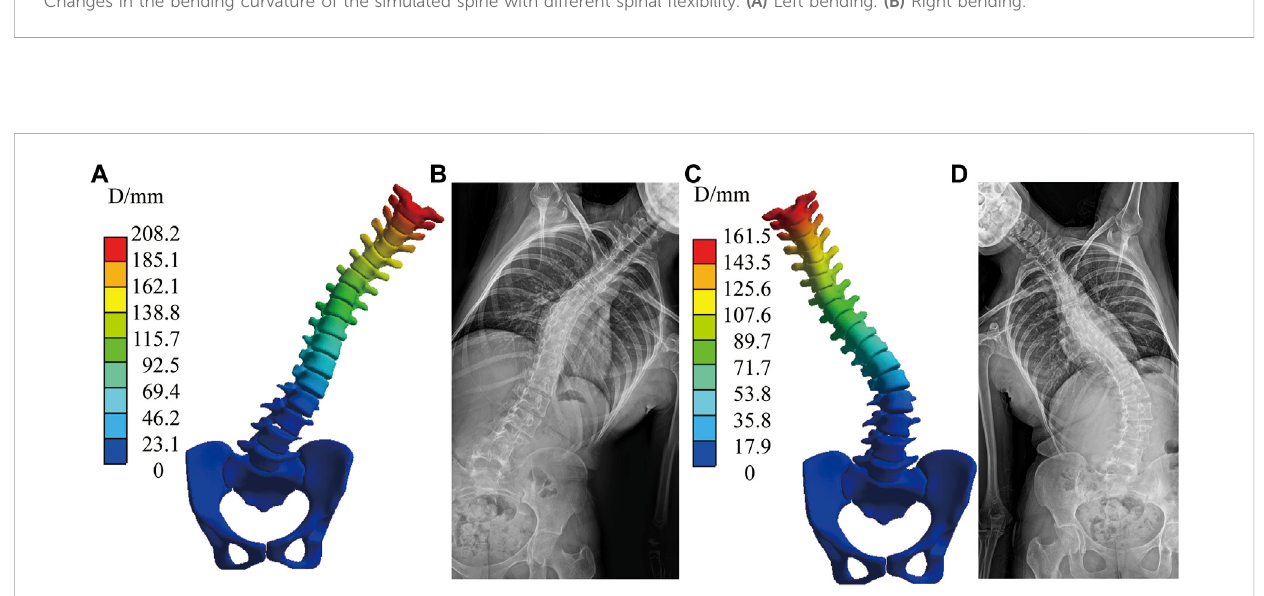
Changes in the bending curvature of the simulated spine with different spinal fl exibility. (A) Left bending. (B) Right bending.